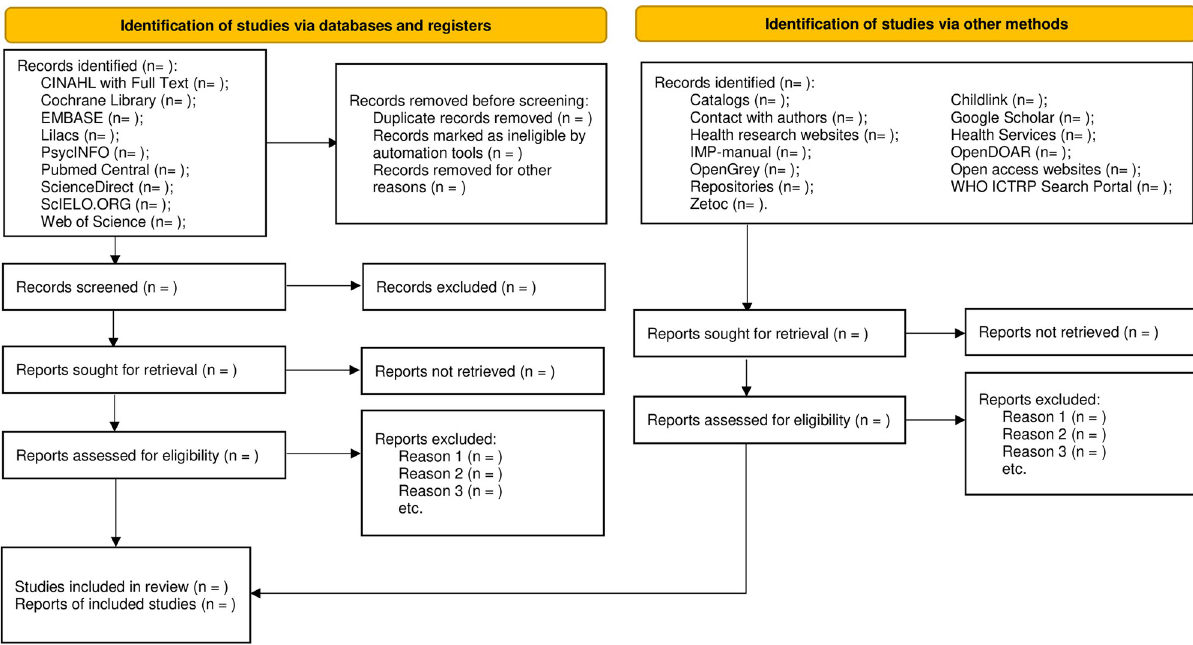
PLOS ONE | https://doi.org/10.1371/journal.pone.0277755 November16,